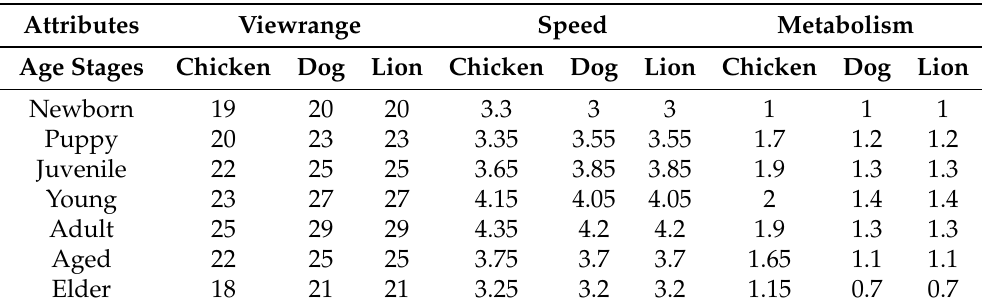
Table 2. Default attributes by age stages. Here, Speed and the Metabolism (Thirst/Hunger) are affected by the evolution system. We created the lions with the same attributes as dogs as a rival predator species, with the only exception that the lions can hunt down the dogs, have longer pregnancy, but no natural enemy.